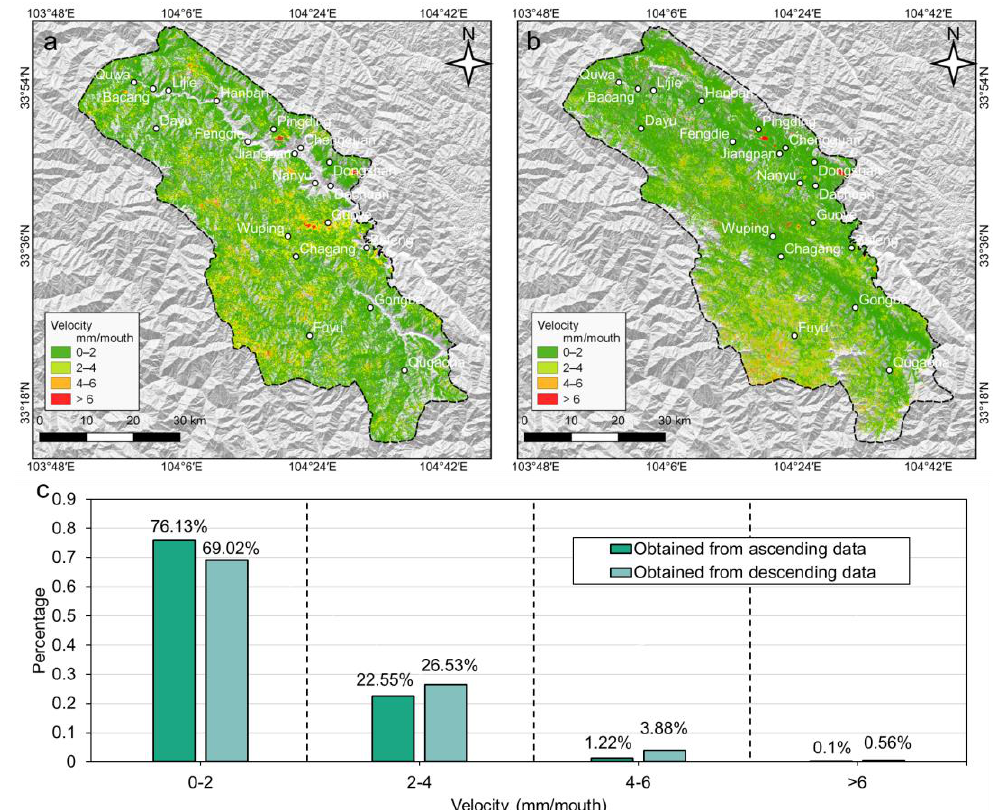
Figure 13. Deformation rate results ( V SLOPE ): ( a ) ascending SAR data deformation rate levels; ( b ) descending SAR data deformation rate results; and ( c ) percentage of data points corresponding to each deformation rate result in V SLOPE .